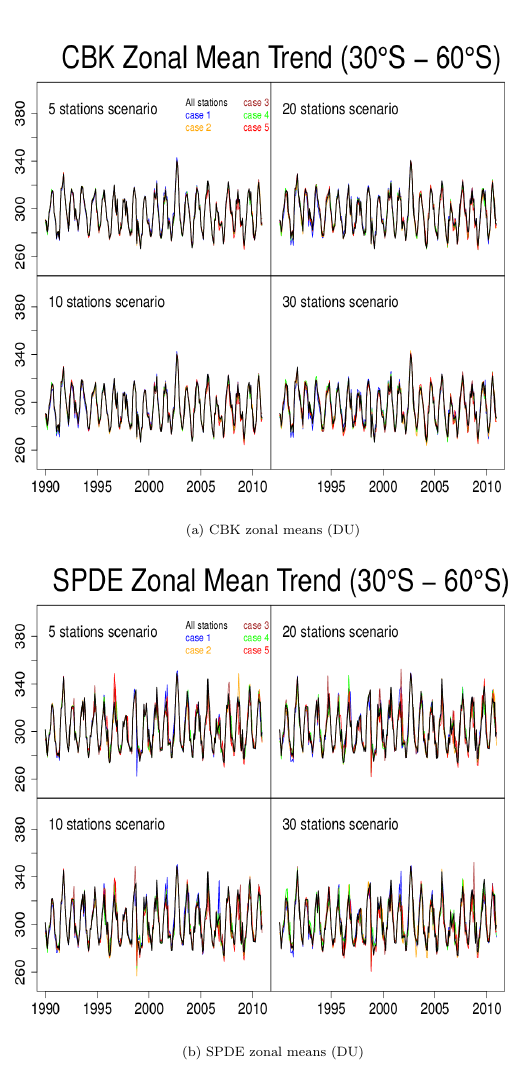
Figure 13. Time series of 30–60 ◦ S zonal means by (a) covariance- based kriging (CBK) and (b) SPDE from 1990 to 2010 for four scenarios with 5, 10, 20 and 30 stations drifted globally.